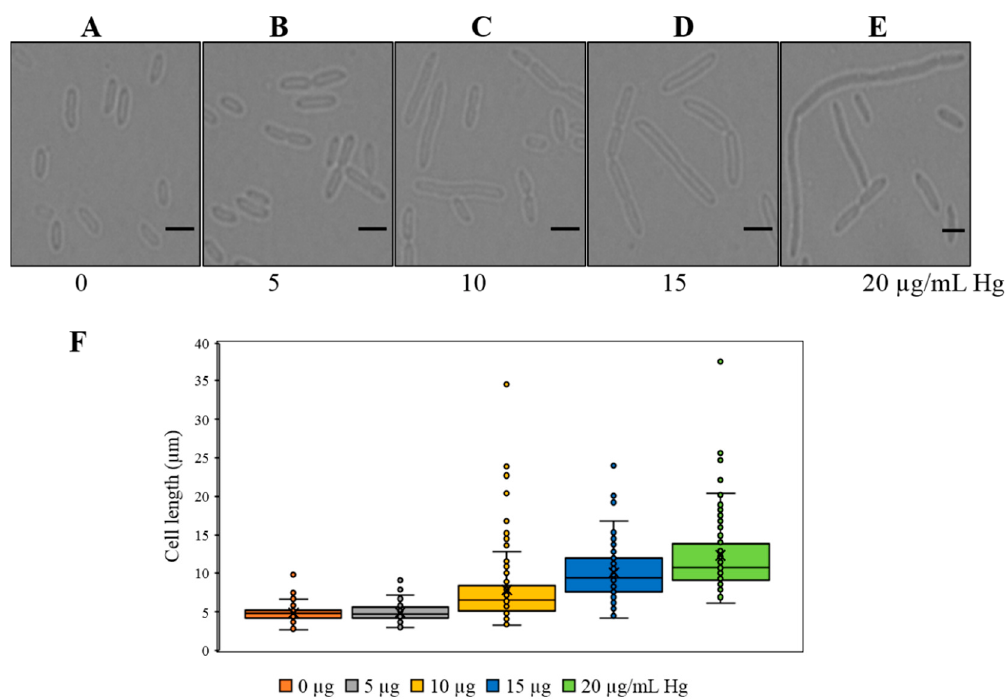
Figure 5. Effect of different Hg concentrations on cell morphology of strain Stenotrophomonas sp. MA5 ( A – E ) representative microscopic images of cells treated with 0 to 20 µg/mL Hg respectively. Scale bar = 5 µm. ( F ) Box plot showing cell lengths measurements. 100 cells were analyzed for each Hg concentration. P values were calculated using one-way ANOVA analysis to calculate the significant difference between control v/s treated cells. For the cells treated with 5 µg/mL Hg was not found significantly different than 0 µg/mL Hg and P value was <1.0. Whereas, cells with 10, 15, 20 µg/mL Hg were found significantly different than 0 µg/mL Hg with a p value of <0.0001.